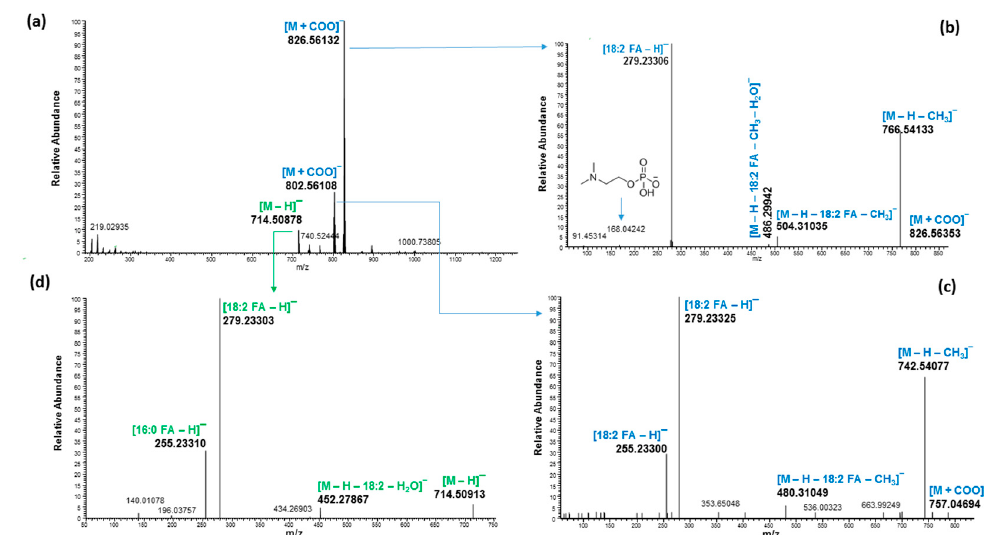
Figure 7. Mass spectra of PCs and PE eluted around 6.60 min with molecular ion at m / z 826.56132, 802.56108 and 714.50878 in negative mode ( a ) fragmentation of PC with molecular ion m / z 826.56132 ( b ), fragmentation of PC with molecular ion m / z 802.56108 ( c ), and fragmentation of PE with molecular ion m / z 714.50878 ( d ).